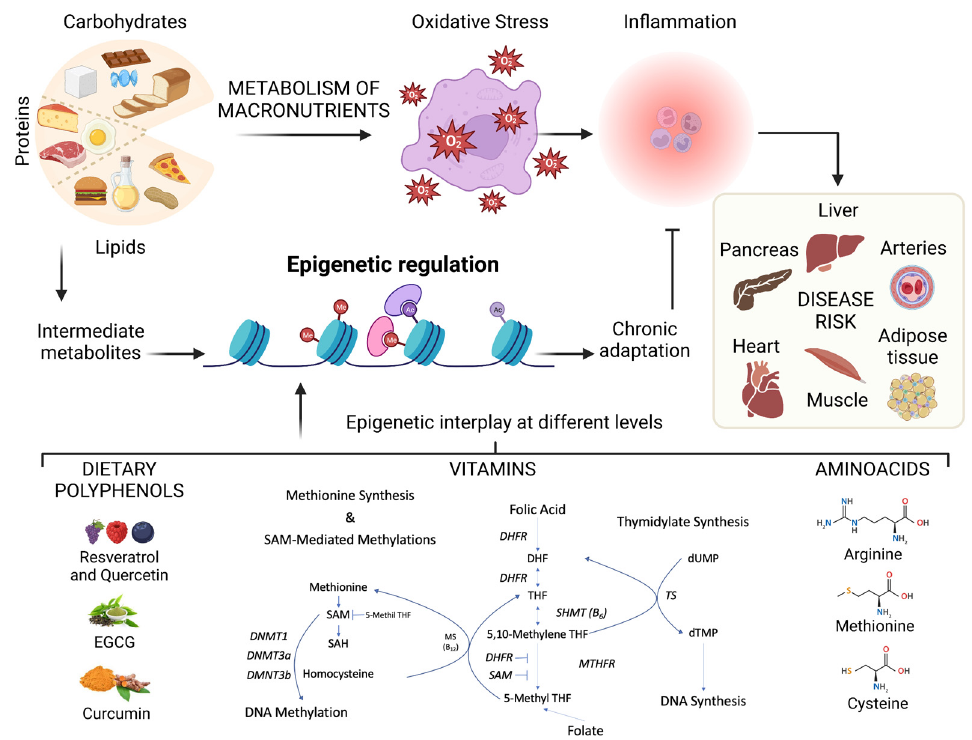
Figure 3. Vitamins linking oxidative stress with epigenetics. The metabolism of dietary macronutrients produces ROS as side-products, which may contribute to inflammation-related diseases. However, intermediate metabolites and other dietary nutrients help the cell to face oxidative stress through epigenetic modulation of genes regulating the stress response. Overview of the metabolism of folic acid for the production of methyl donors (for DNA methylation). Created with biorender.com.